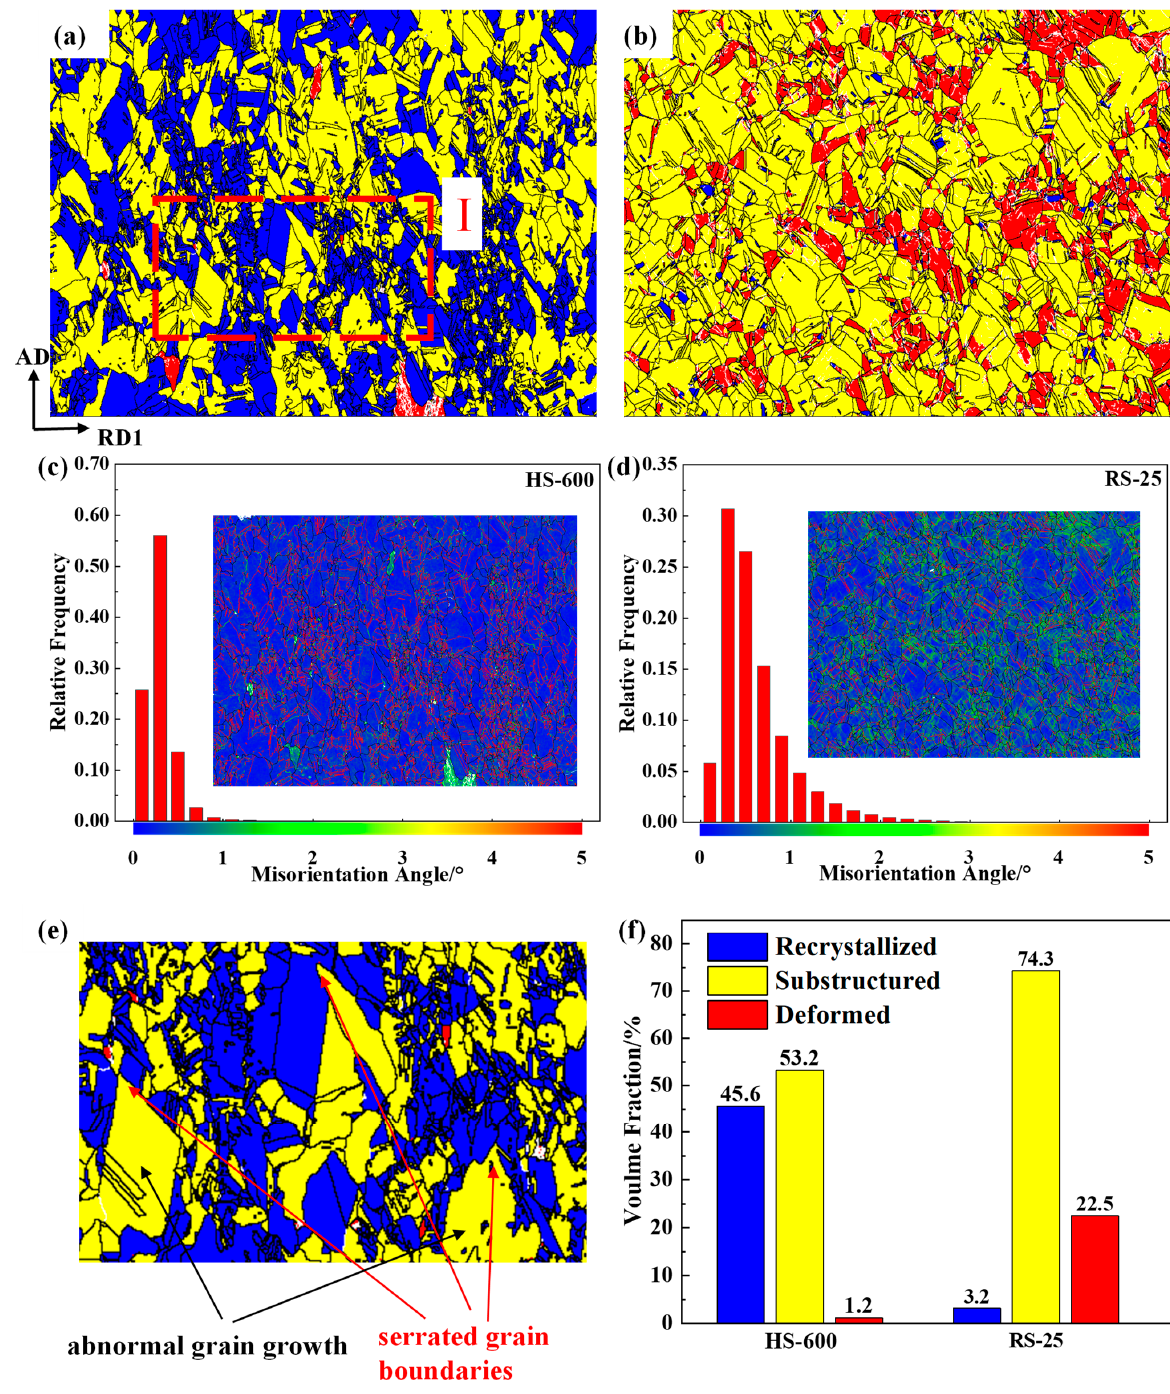
Figure 5. Recrystallization maps and the KAM statistics data for ( a , c ) HS-600 and ( b , d ) RS-25, respectively; ( e ) an enlarged image of the encircled area I in Figure 5a; and ( f ) the statistics data of recrystallization maps.